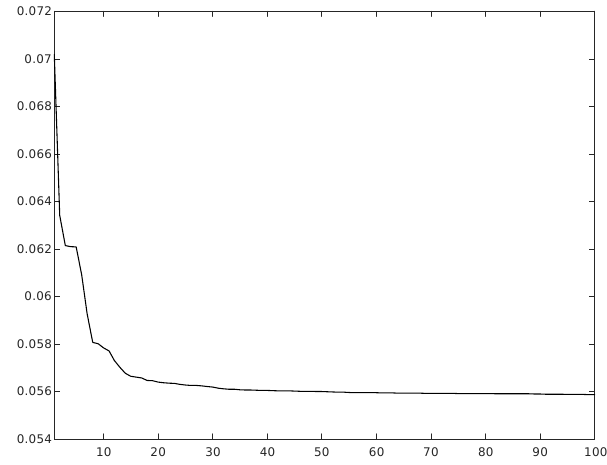
Figure 7: Approximated Optimal Control